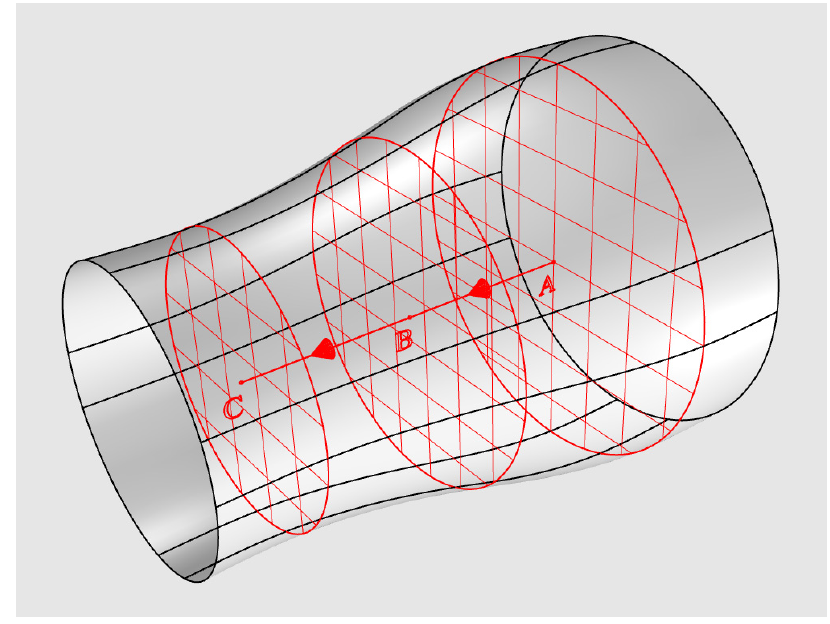
Figure 1. Stream tube of ideal propulsor based on the momentum theory. Source: Authors based on [19].